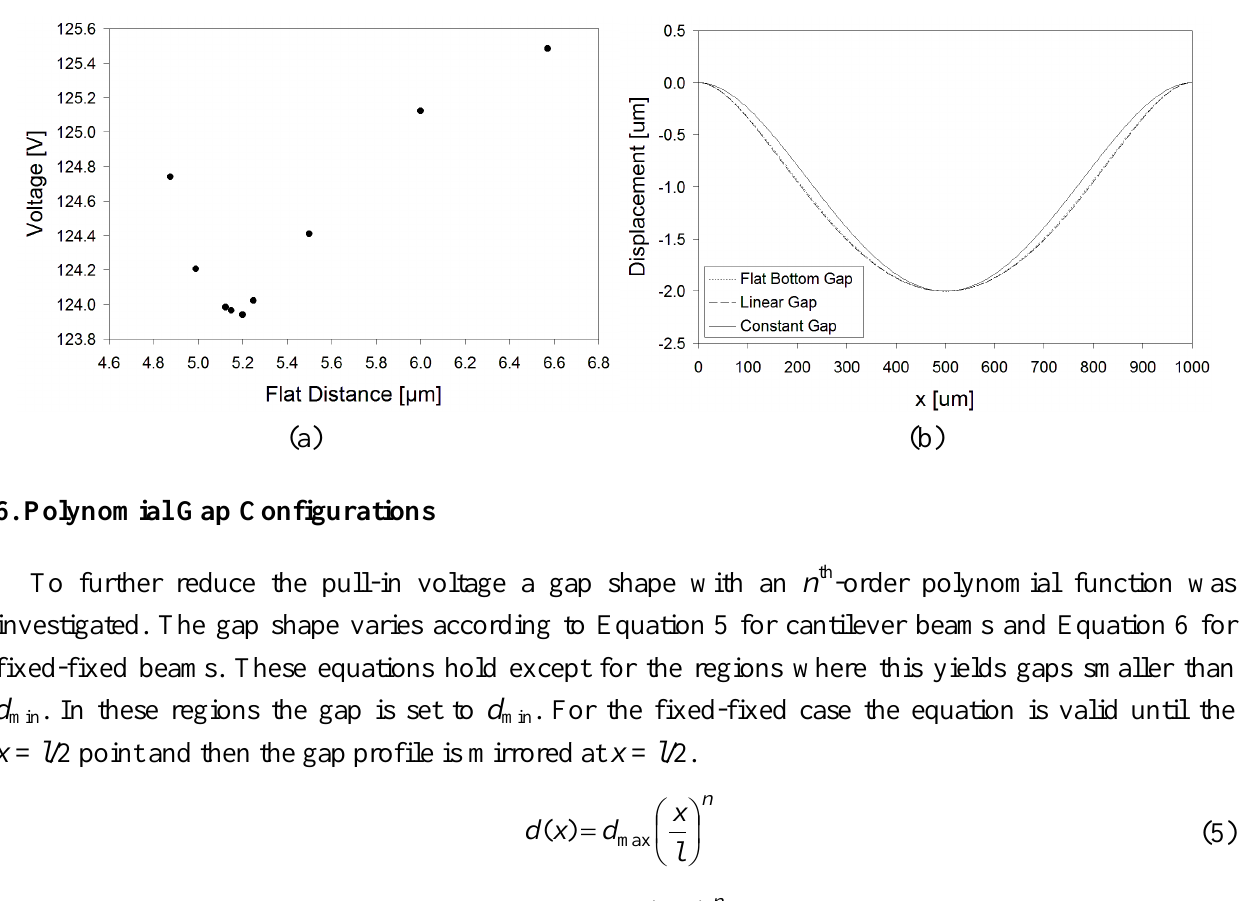
Figure 9. Results for flattened bottom case (a) pull-in voltage (b) beam displacement profile ( d = 5.20 flat